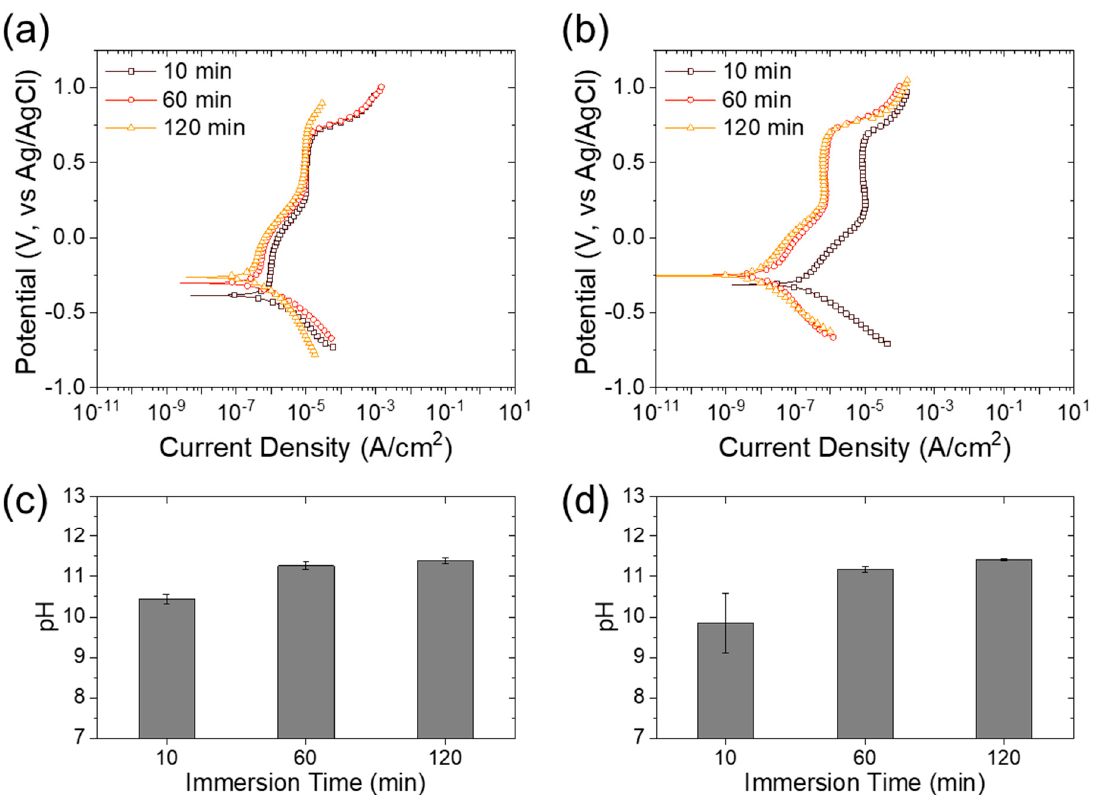
Figure 5. XPS core-level spectra of ( a ) Cr 2p3/2 and ( b ) Mn 2p3/2 of Fe-based shape memory alloy immersed in deionized water for a day with various pH values, adjusted by CaO.